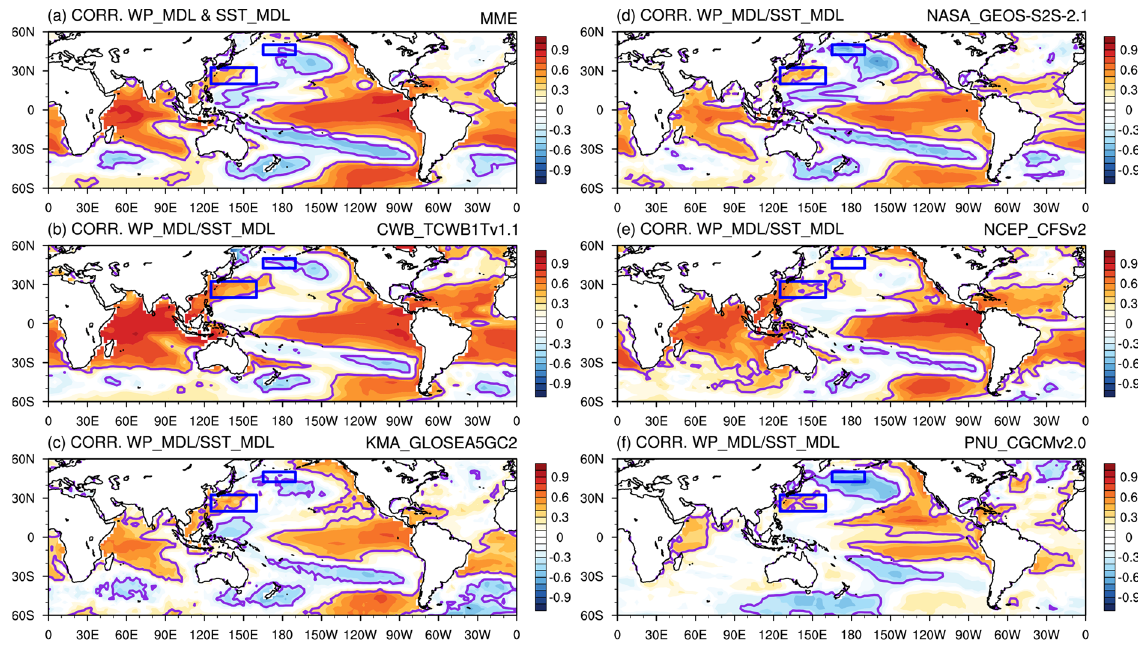
Figure 8. Correlation patterns between Z500 and the WP index predicted by the ( a ) MME ( b – f ) and individual models for the entire series. Blue boxes enclose the areas of SST averaging used for the estimation of the NWP index. Significant at the 95% confidence level values are enclosed by a thick line.